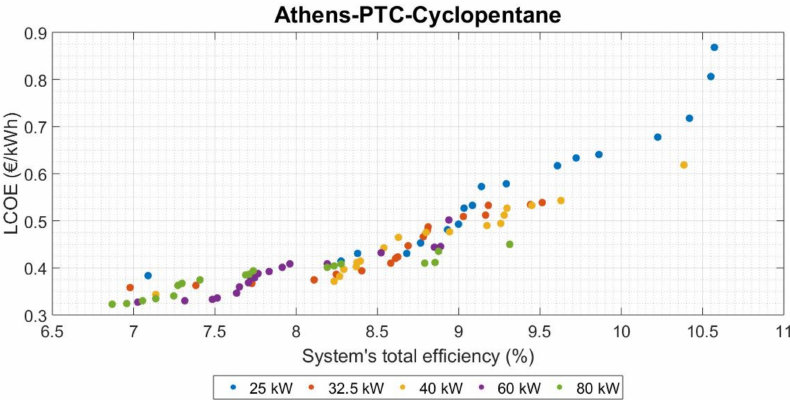
Figure 9. Pareto fronts of PTC-driven ORCs of different nominal heat input values located in Athens and operating with